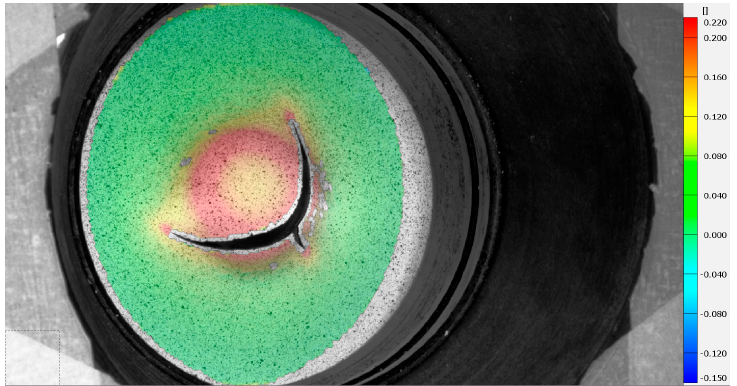
Figure 4. Al99 sample plate with P9/SC9 painting and cleaning process (dimensions are in mm).